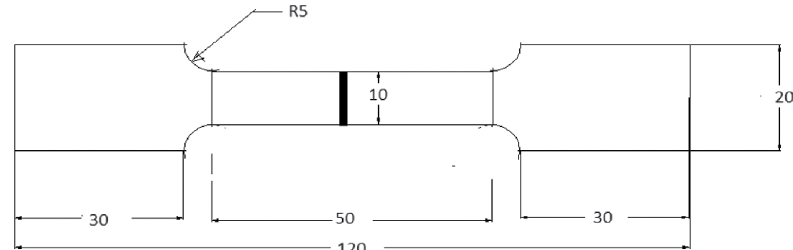
Figure 2: Schematic diagram of the specimen.